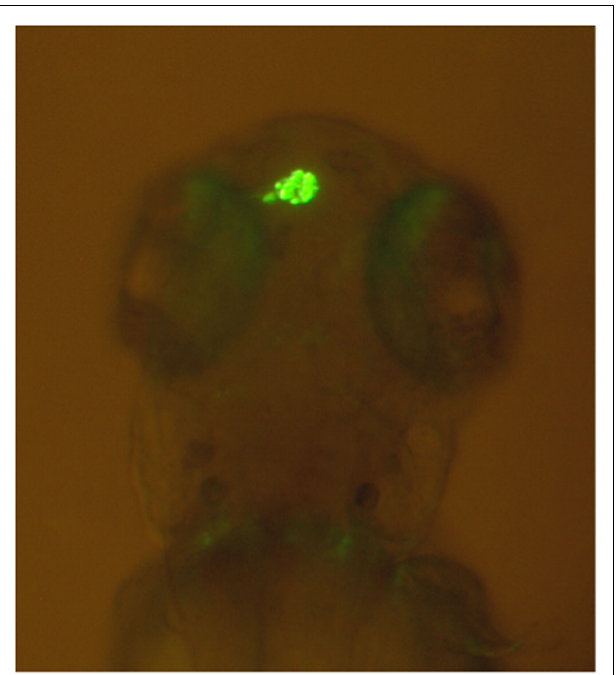
FIGURE 3 | Leftward asymmetry of the parapineal organ in a zebrafish made visible by green fluorescent protein expression in a transgenic tg(foxD3:GFP)zf15 zebrafish (Modified from Dadda et al., 2010b). Rostral is upward and caudal is